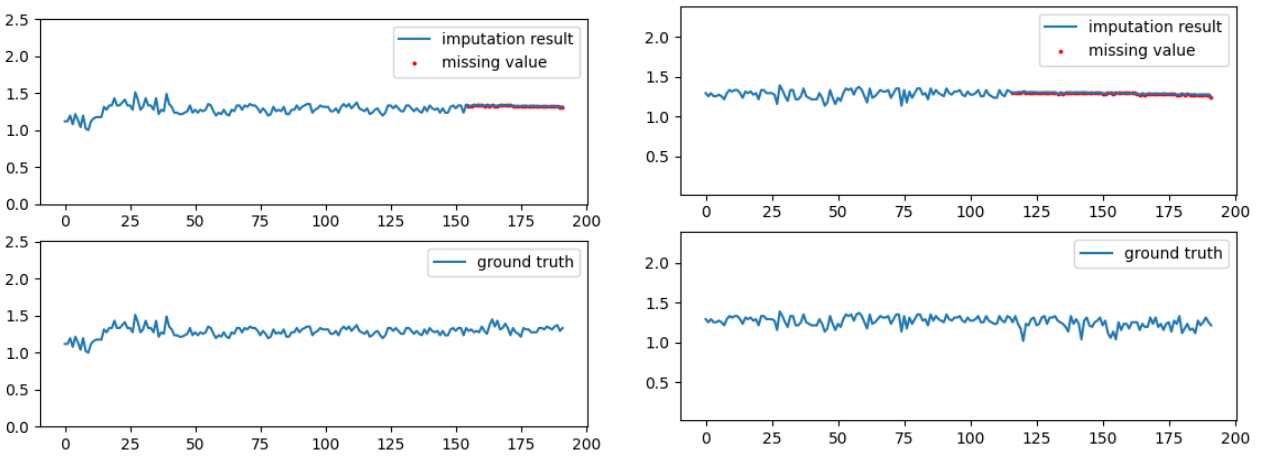
Figure 5. Imputation results of informer-WGAN method on CMG dataset at missing rates of 20% and